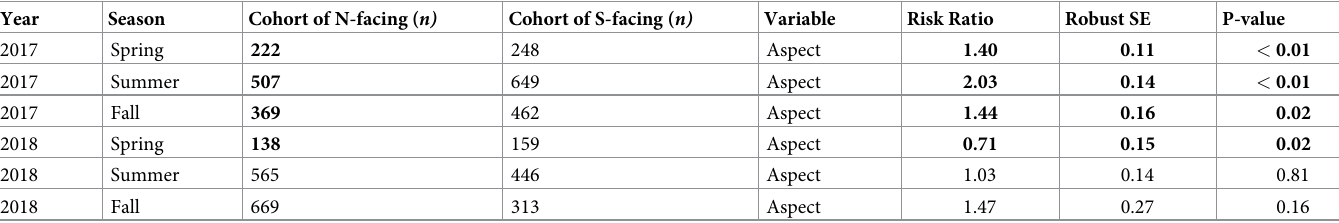
Table 3. Proportional hazards table for the effect of aspect (south or north facing) on root survivorship in different years and seasons.